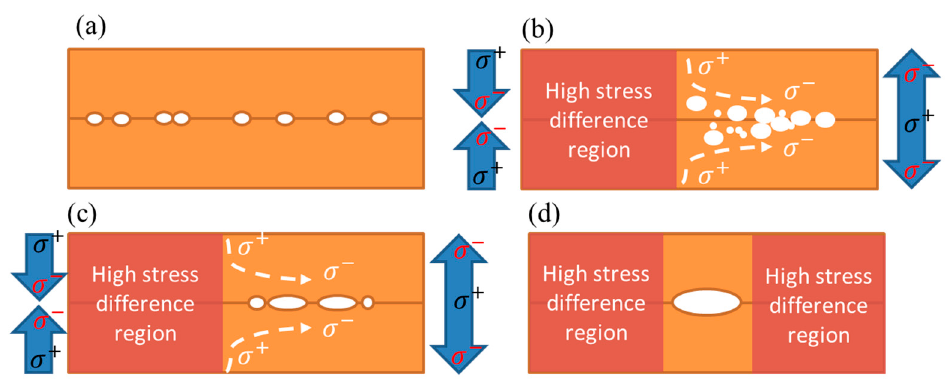
Figure 8. Movement mechanism of interfacial voids in the joints. Various voids pre-exist at the bond- ing interface of the as-bonded joints ( a ). Under thermal cycling, these voids tend to migrate toward the low stress regions ( b ). Voids merge together until the void density reaches a steady state ( c ). A large void forms between two high stress regions ( d ).